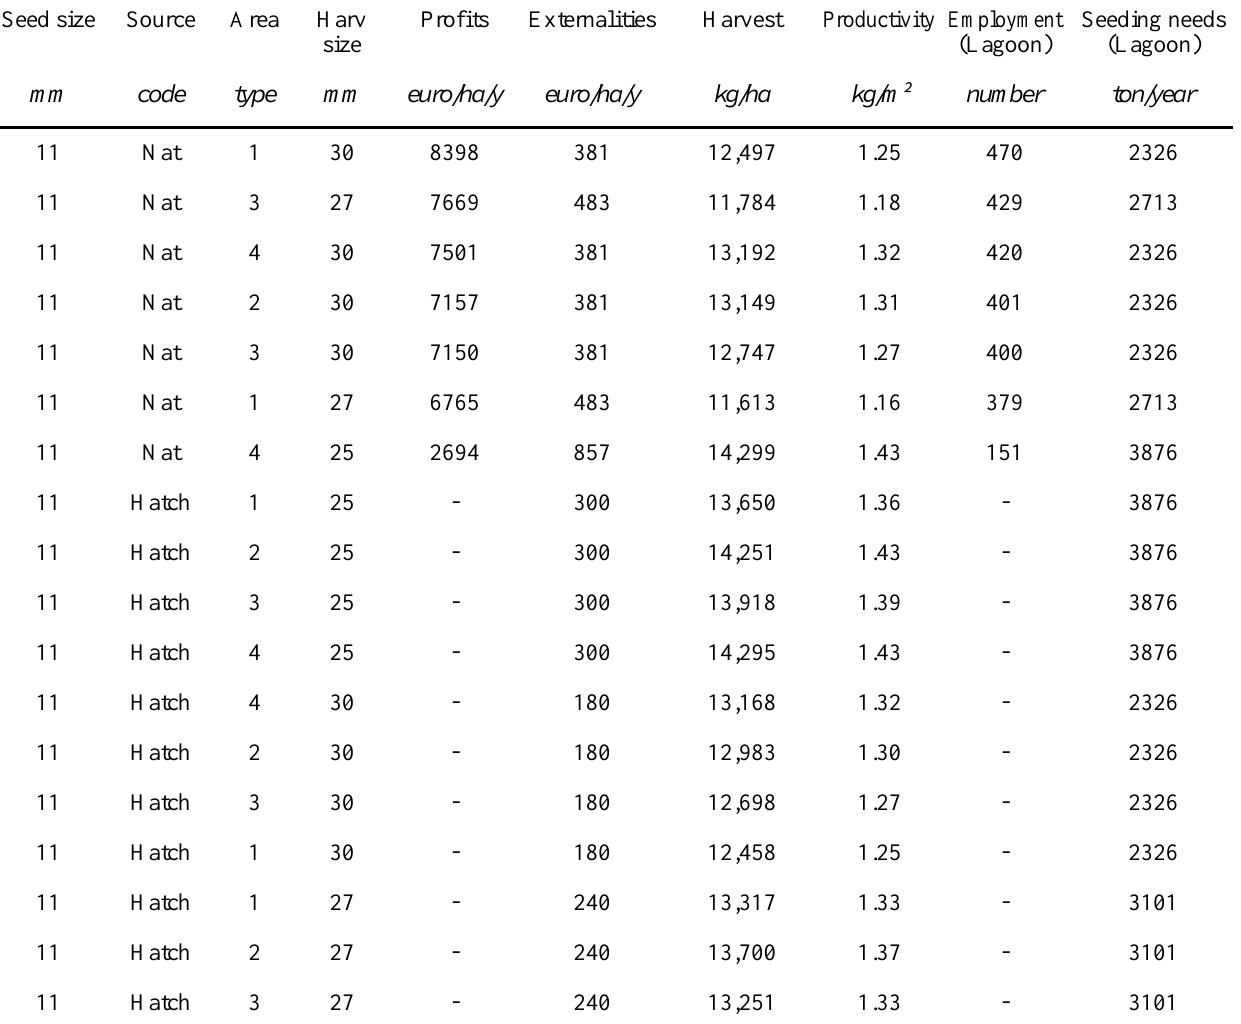
Table 8. Sensitivity analysis to reduced price -2 euro. Selected scenarios (rows) changing model parameters (columns 1-4). Columns 5-10: scenario results using selected indicators (profits, externalities, harvest, productivity, maximum employment, and seeding